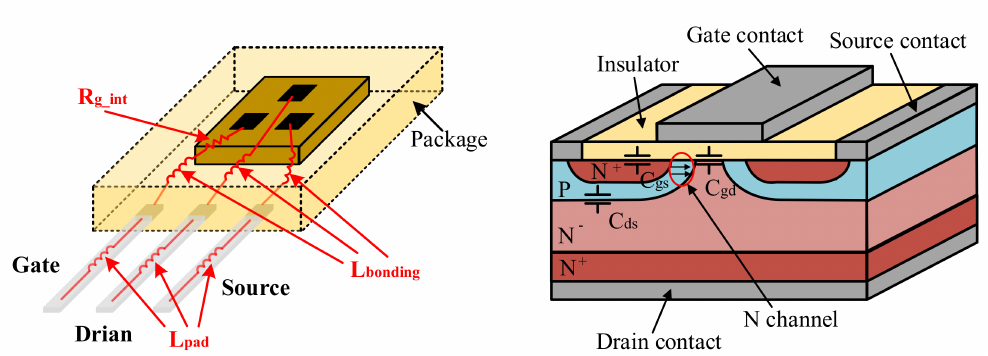
Figure 1. Simplified physical view of a power MOSFET with the package.